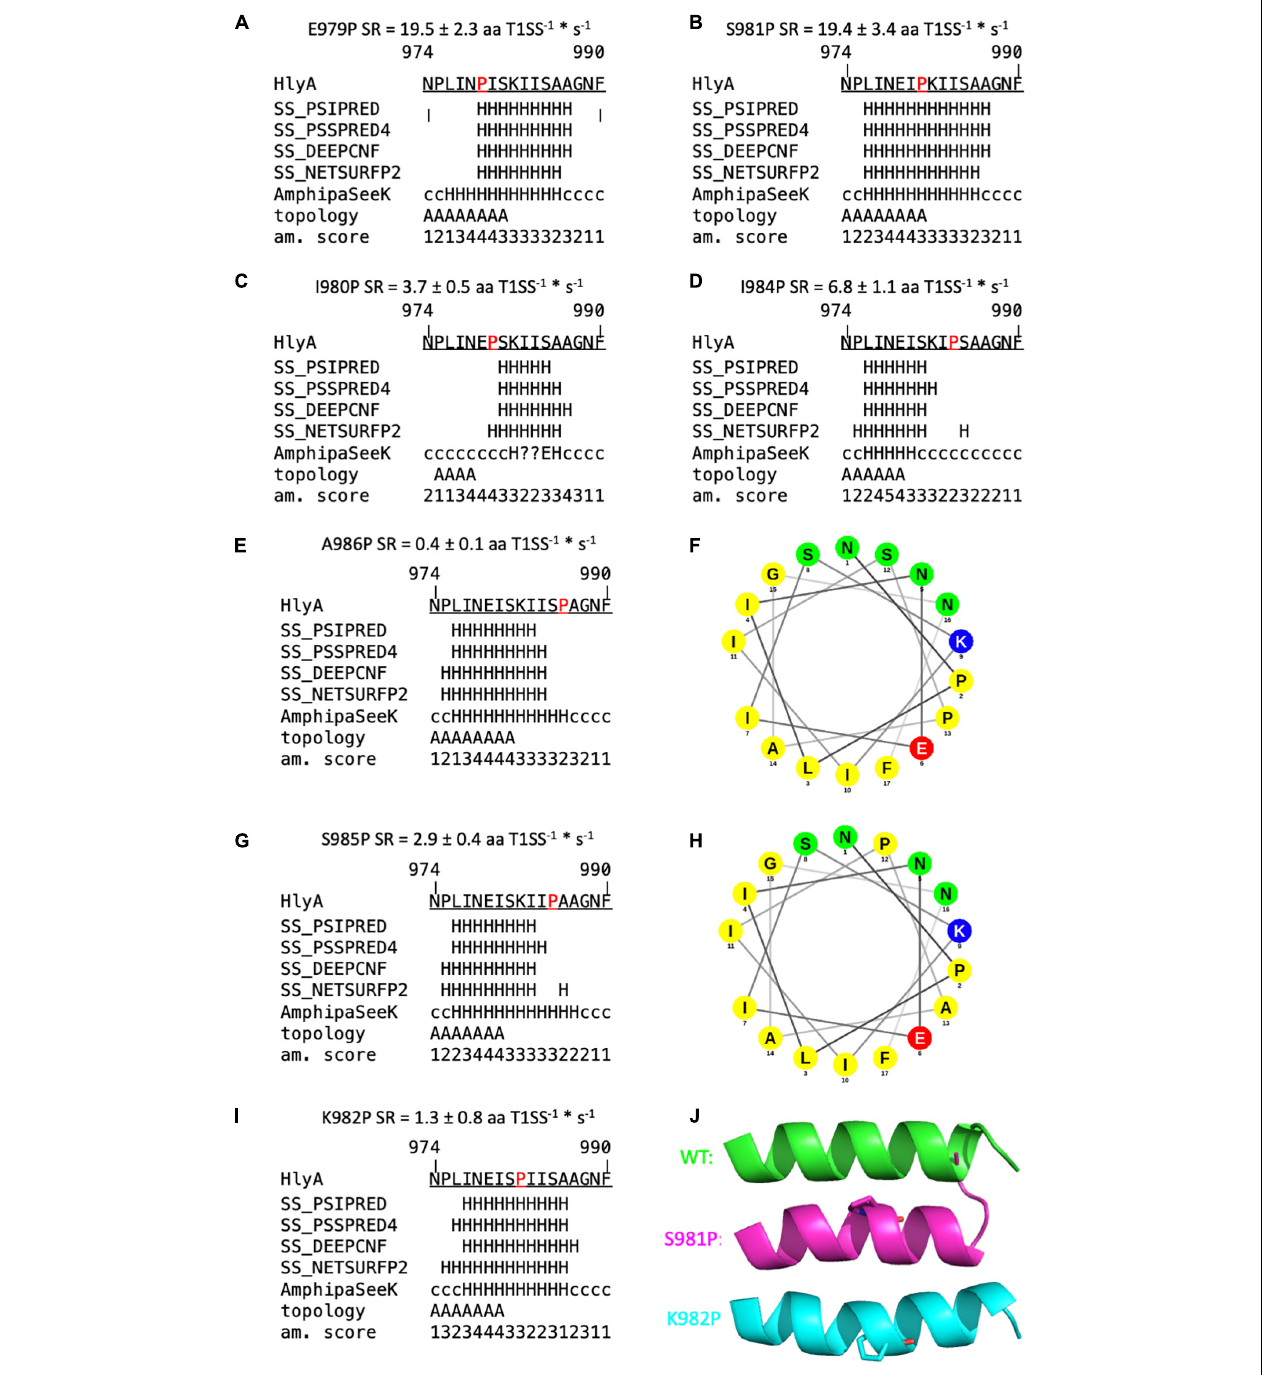
FIGURE 6 | Secondary structure predictions of mutants of the secretion signal of HlyA. Predictions labeled with “SS” are derived from Quick2D. Topology = predicted by AmphipaSeeK, “A” indicated those residues that are predicted to be inserted parallel into the membrane. Am. score = amphipathy score predicted by AmphipaSeeK with 1 = lowest amphipathy and 5 = highest amphipathy. H = α -helix, c = coiled coil, E = β -sheet, ? = no prediction. Mutated residues are marked in red. Secretion rate (SR) is given for each mutant as mean ± SD of three independent measurements. (A,B) Single proline mutations with SR similar to wild type pro-HlyA. (C,D) Single proline mutations with reduced SR compared to the wild type protein. (F,H) Helical wheel projection of A986P (F) and S985P (H) . Non-polar residues are colored yellow, lysine blue, glutamate red and polar residues green. Proline at position 985 reduces the polarity on the polar site of the amphipathic α -helix compared to wild type HlyA ( Figure 1B ). (E,G,I) Proline substitutions with drastically reduced SR. (J) Cartoon representation of PEP-FOLD3 models of wild type pro-HlyA (green), S981P (pink) and K982P (cyan). Mutated proline residues are shown as sticks. All models have an identical orientation for comparison. K982P and S981P bend the helix in opposite